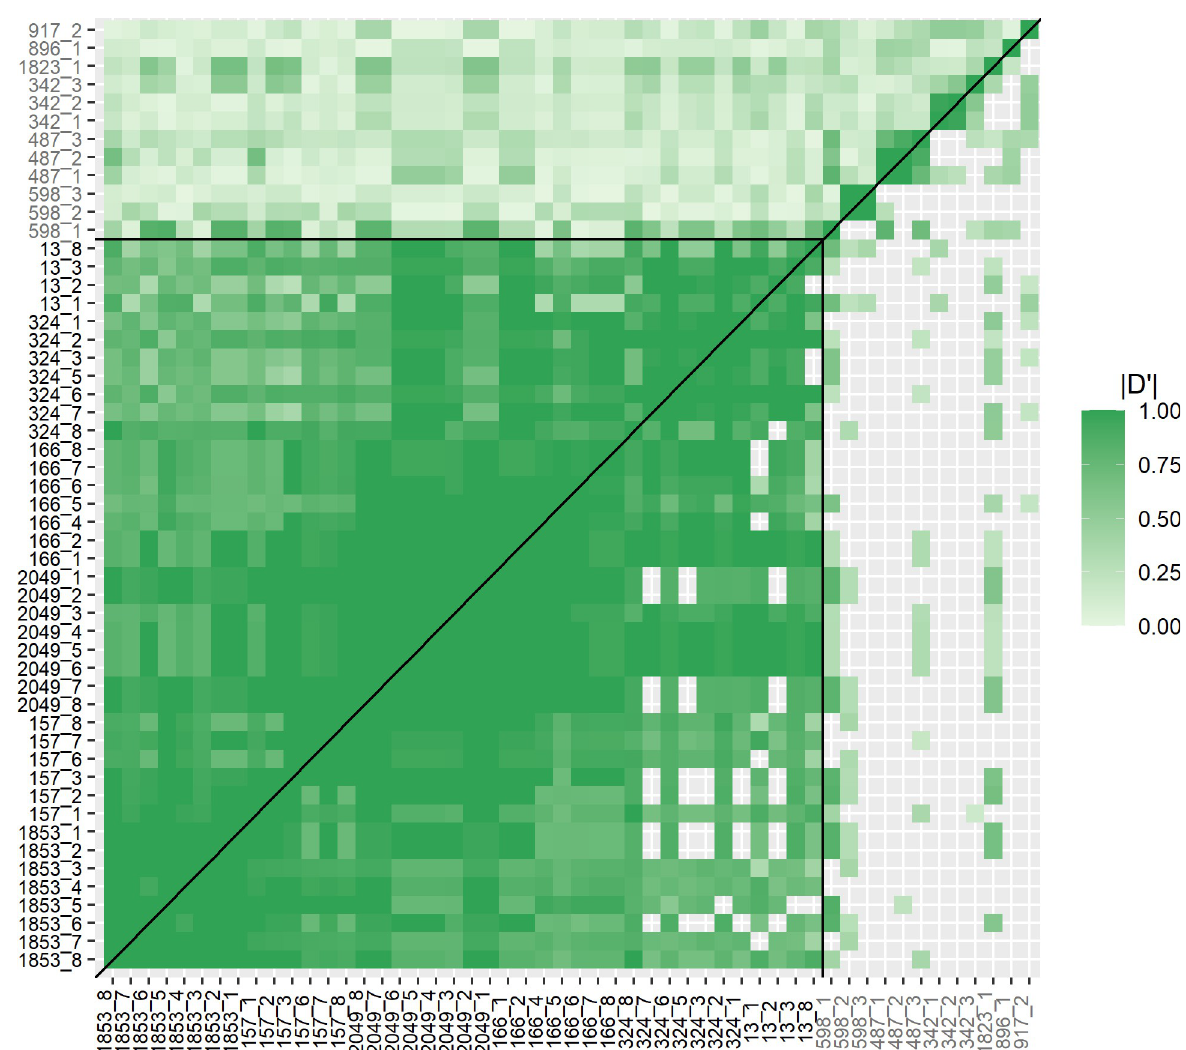
Fig 3. Heat map (with no clustering or scaling) to show |D’| values between all pairs of loci in untreated F2 parasites. Loci under selection are enclosed by the black horizontal and vertical lines, with neutral loci outside. Above the diagonal all |D’| values are shown and below the diagonal only |D’| values with significant q -values ( q < 0.05 after false discovery rate correction) are shown. When comparing pairs of loci from scaffolds under selection, high |D’| values indicate that all six scaffolds are in linkage disequilibrium. The |D’| values for the majority of loci pairs containing neutral scaffolds are low or